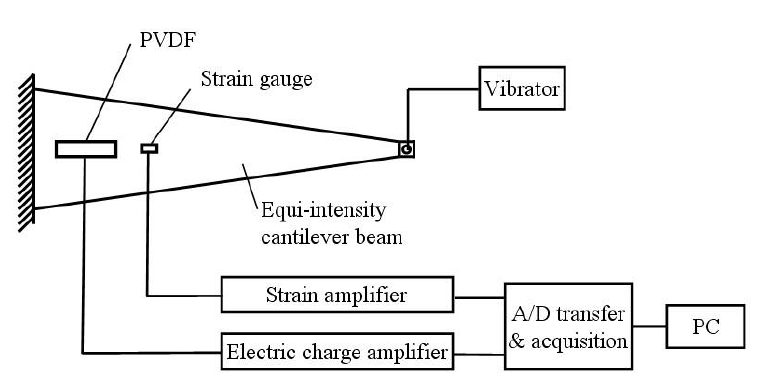
Figure 15. Scheme of sensitivity calibration test of